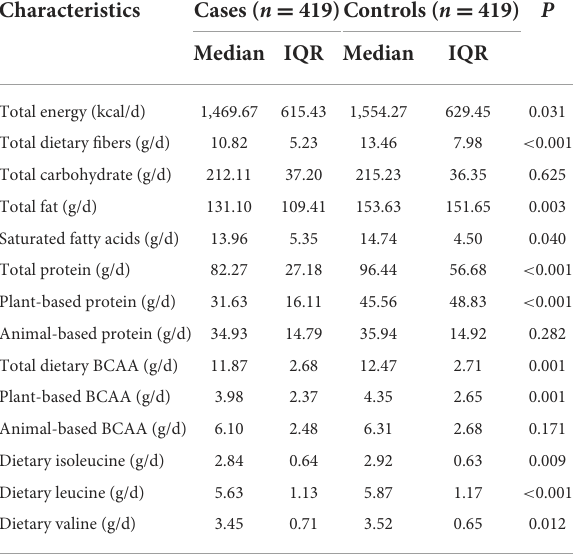
TABLE 3 Daily dietary nutrients and food group intake after energy-adjusted among 419 pairs of cases and controls. Characteristics